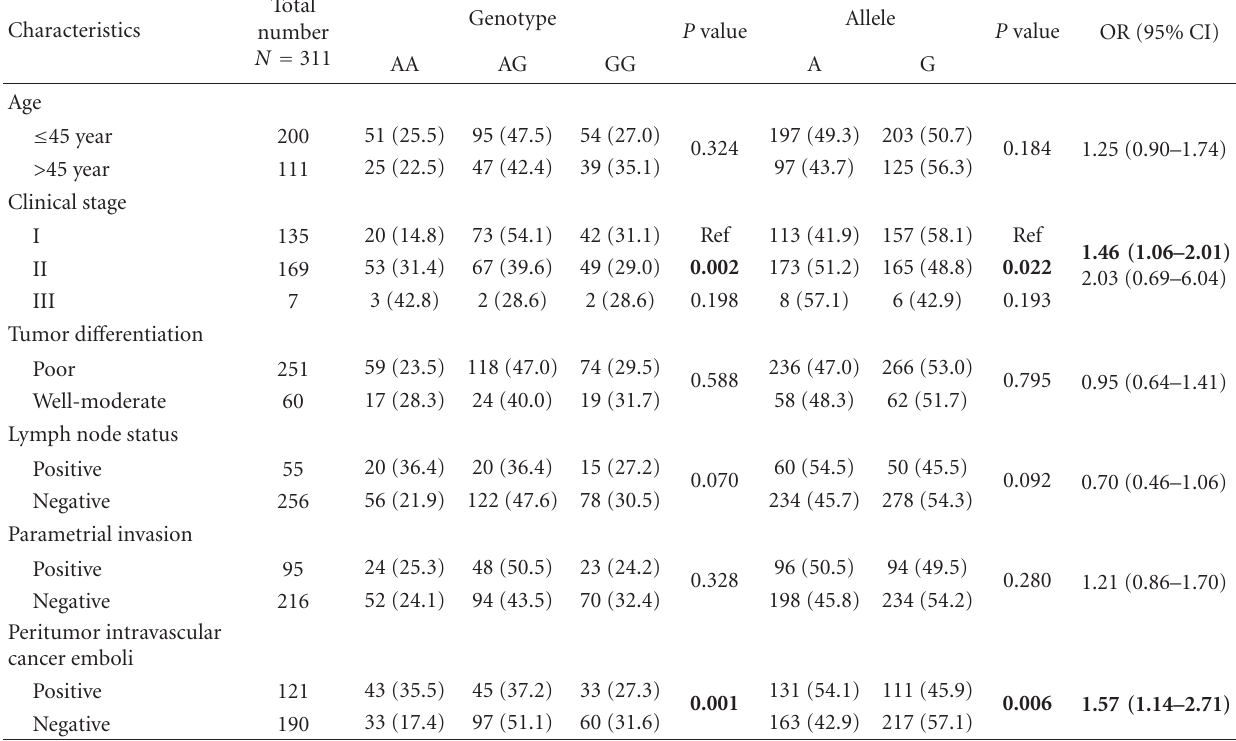
Table 2: Analysis of patient characteristics and polymorphism of locus